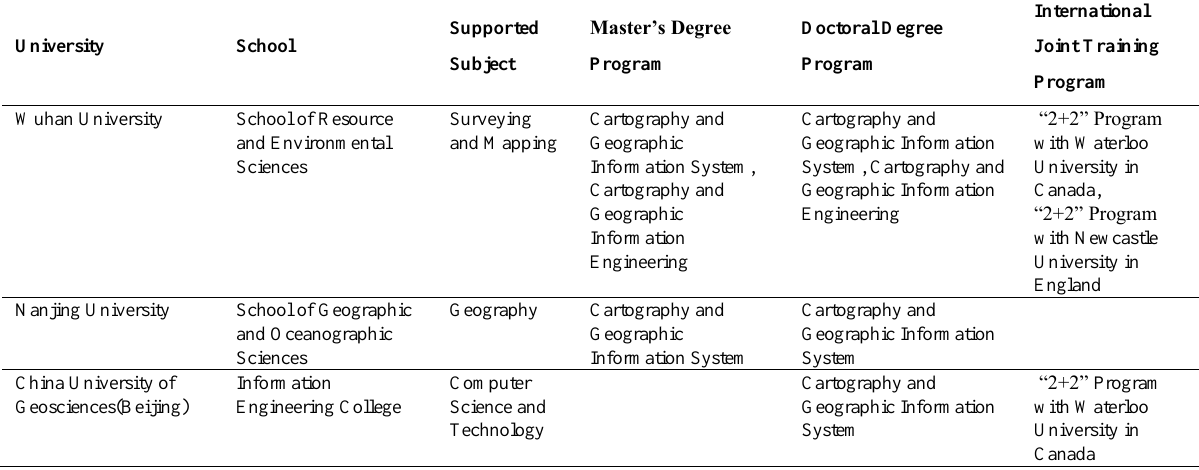
Table 1. Summary of GIS Specialty in Wuhan University, Nanjing University and China University of Geosciences (Beijing) University